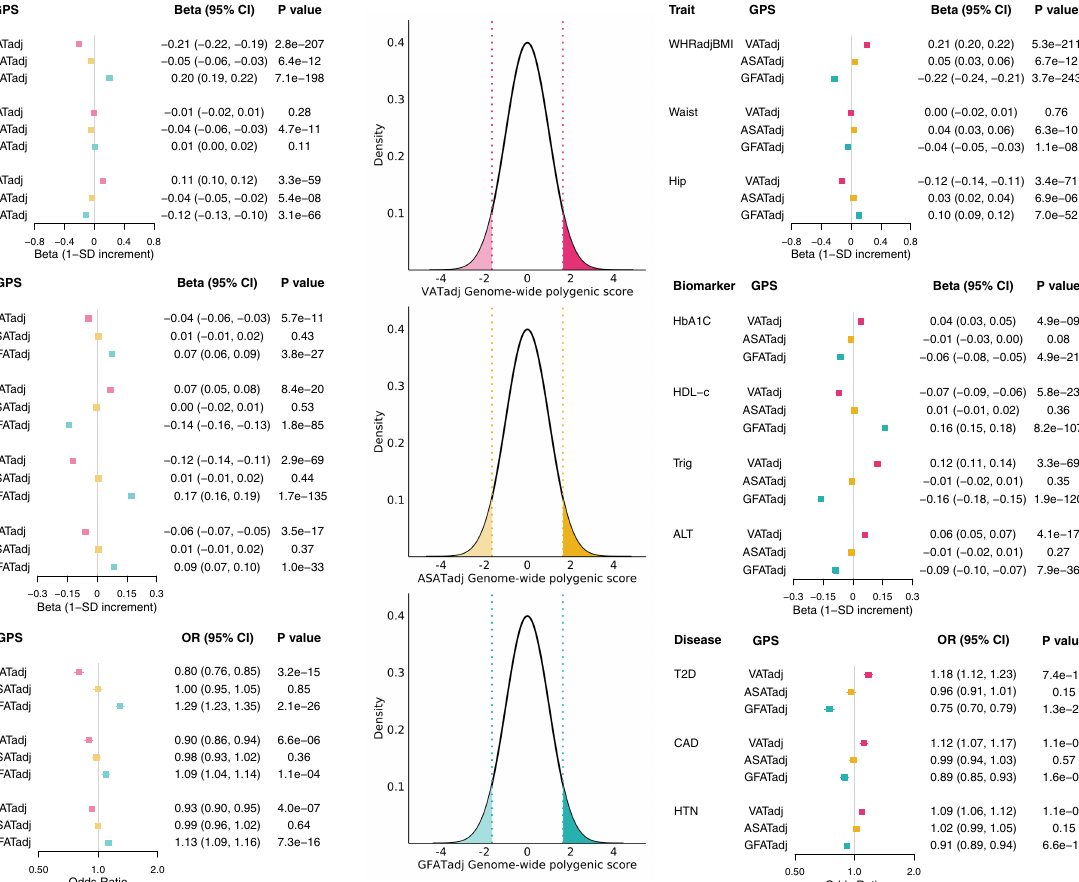
Fig. 7 Effects of VATadj, ASATadj, and GFATadj polygenic scores on metabolically relevant biomarkers and diseases. The central density plots indicate the distributions of VATadj, ASATadj, and GFATadj polygenic scores in genotyped individuals of the UK Biobank who were not imaged ( N = 447,486). The dotted lines and shaded regions correspond to individuals in the top 5% and bottom 5% of the polygenic score. Forest plots to the right correspond to effect sizes of an indicator variable for being in the top 5% of the polygenic score (with identical color-coding to the density plots), while forest plots to the left correspond to effect sizes of an indicator variable for being in the bottom 5% of the polygenic score. Each polygenic score was residualized against the fi rst ten principal components of genetic ancestry prior to being discretized, and each regression was adjusted for age at imaging, sex, and the fi rst ten principal components of genetic ancestry. HbA1C hemoglobin A1C, HDL-c HDL-cholesterol, Trig triglycerides, ALT alanine aminotransferase, T2D prevalent type 2 diabetes (at time of imaging), CAD prevalent coronary artery disease, HTN prevalent hypertension. Corresponding data are found in Supplementary Data